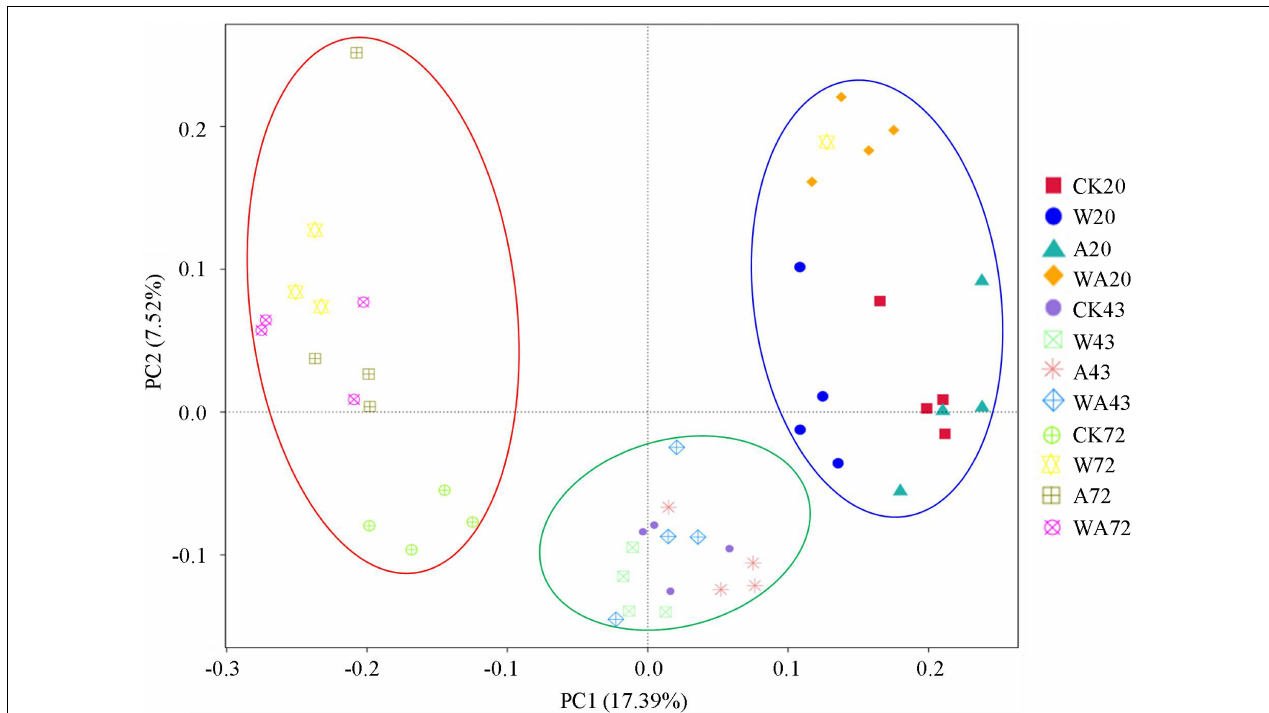
FIGURE 1 | Principal coordinates analysis (PCoA) based on the relative abundance of 16S rRNA genes from 48 samples (4 treatments × 3 periods × 4 replicates per period). The scatterplot shows principal coordinate 1 (PC1) vs. principal coordinate 2 (PC2). The percentages of variation in the samples described by the plotted PCs are shown on the axes. The 4 replicates for each period are represented by a single color. CK, control; W, warming treatment; A, acidification treatment; WA, acidification and warming treatment. 20, 43, and 72: samples were collected at 20, 43, and 72 days.